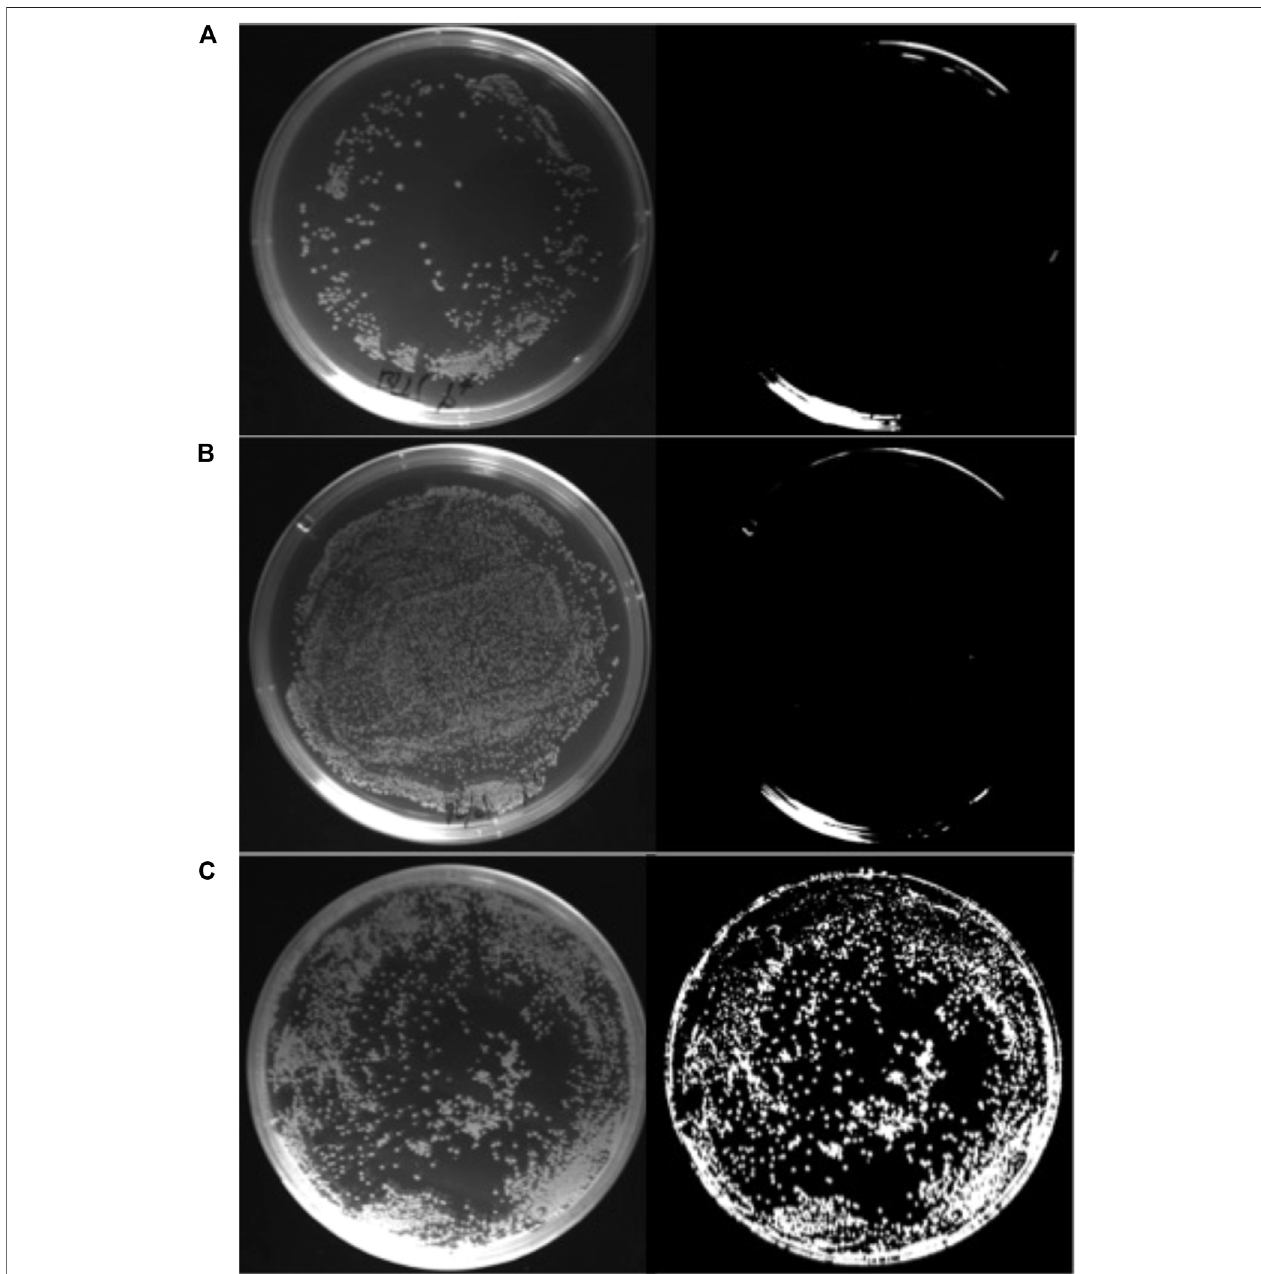
FIGURE 4 | Nile red stain assay of (A) E. coli BL21 (DE3), (B) E. coli BL21 (DE3)/pPHB01 (C) E. coli BL21 (DE3)/pPHB01-1. The LB agar plate contained 10 g/L glucose and 0.8 mg/ml nile red without ampicillin. The plate on the left and right in each panel was taken under white light and monochromatic light at 470 nm,